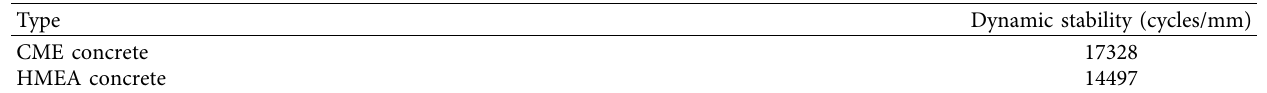
Table 13: Wheel tracking test results of CME and HMEA